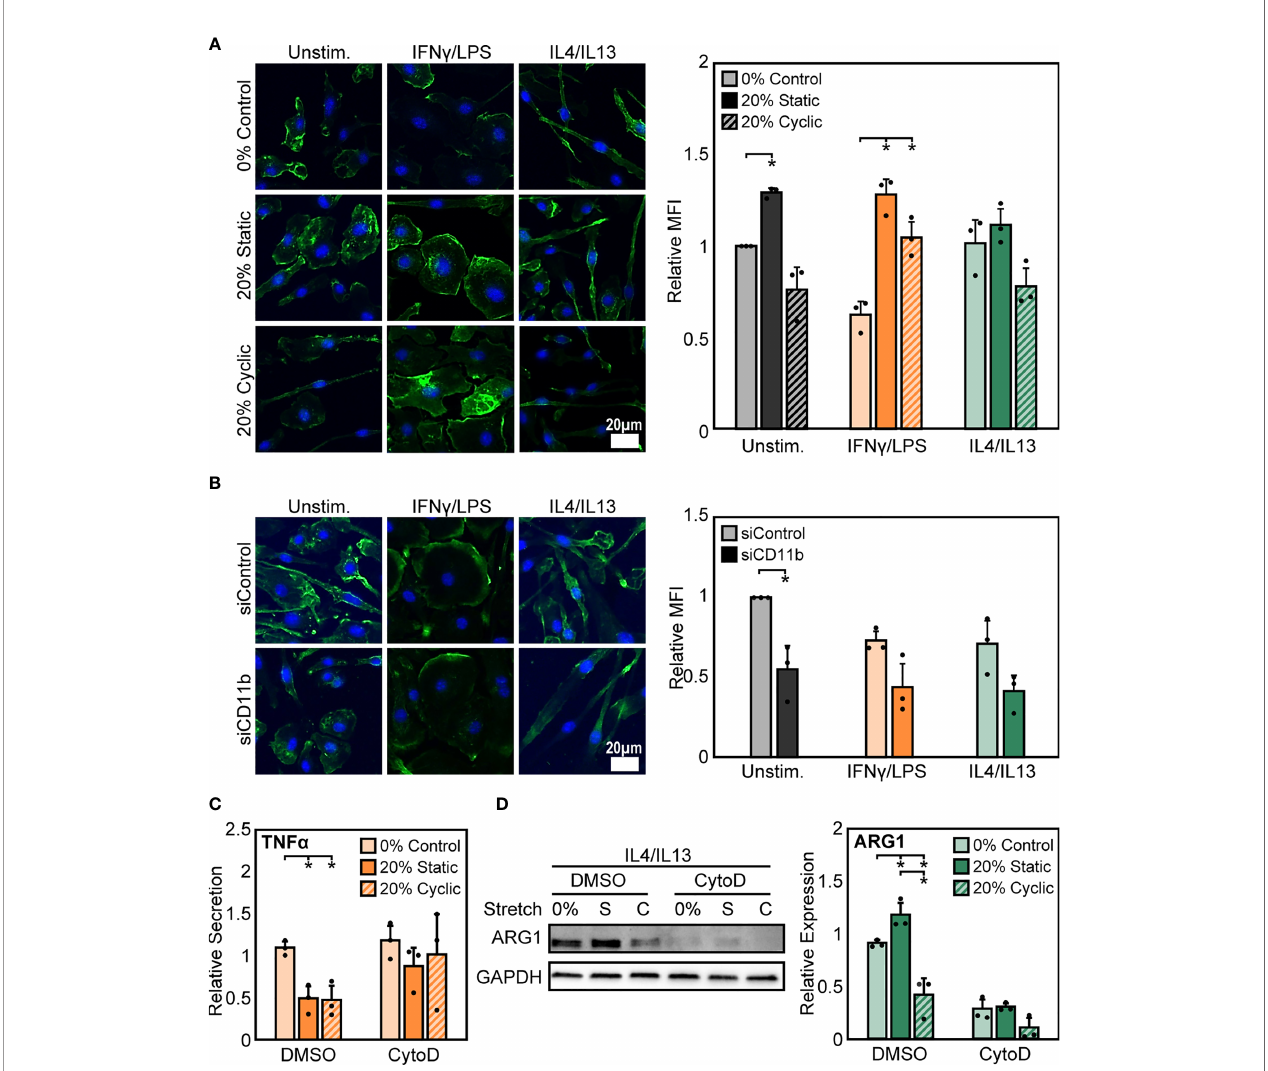
FIGURE 6 | Stretch-induced changes in macrophage activation require modulation of actin. (A) Representative images of F-actin in unstimulated, IFN g /LPS, and IL4/IL13 stimulated macrophages exposed to 0%, 20% static, and 20% cyclic stretch. Quanti fi cation of mean F-actin fl uorescence intensity across three independent experiments (right). Data normalized to the unstimulated and 0% stretch control. (B) Representative images of F-actin in unstimulated, IFN g /LPS, and IL4/IL13 stimulated macrophages exposed to siControl or CD11b siRNA. Quanti fi cation of mean F-actin fl uorescence intensity across three independent experiments (right). Values normalized to unstimulated and siControl condition. (C) Secretion of TNF a in IFN g /LPS stimulated macrophages treated with DMSO or CytoD and exposed to 0% and 20% static or cyclic strains. Values are normalized to a DMSO, 0% stretch, and IFN g /LPS stimulated internal control within each biological replicate. (D) Representative Western blot (left) and quanti fi cation of ARG1 expression in IL4/IL13 stimulated macrophages treated with DMSO or CytoD and exposed to 0% and 20% static or cyclic strains. Expression is relative to GAPDH. Error bars indicate standard deviation of the mean for three separate experiments and * p < 0.05 when compared to the corresponding 0% stretch condition as determined by paired t-test (A, B) and Student ’ s t-test (C, D)